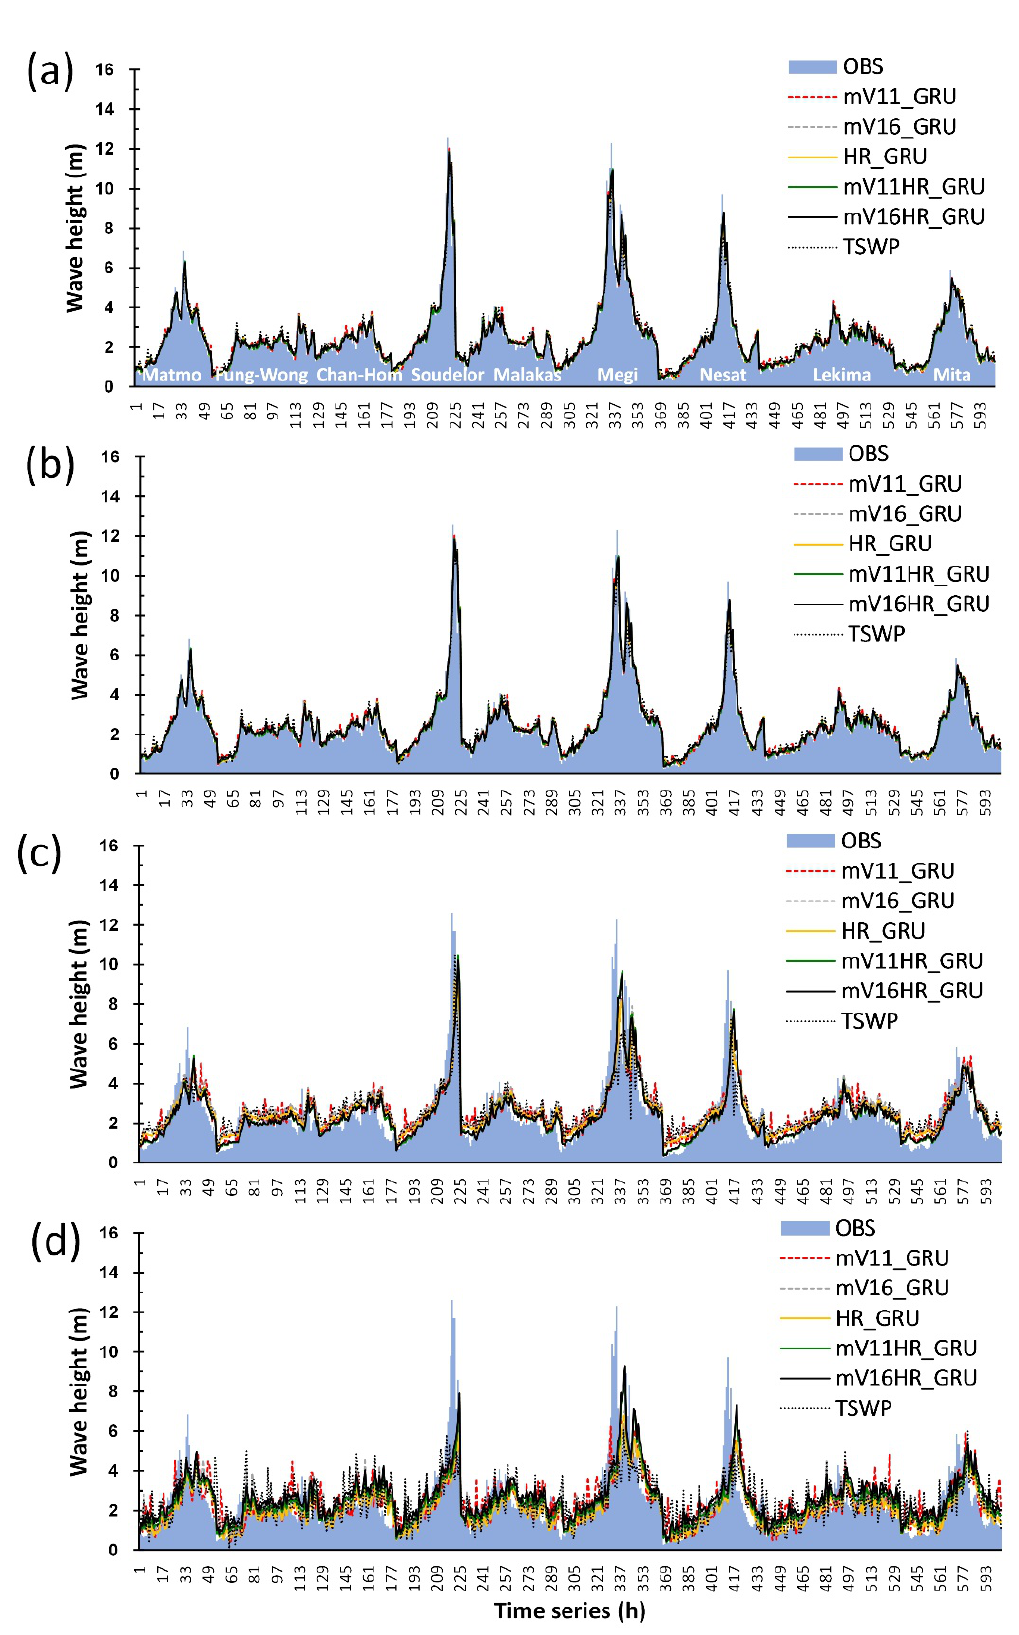
Figure 9. Wave heights predicted and measured using mV11_GRU, mV16_GRU, HR_GRU, mV11HR_GRU, mV16HR_GRU, and TSWP at the Guishandao buoy at the following lead times: ( a ) t + 1, ( b ) t + 2, ( c ) t + 4, and ( d ) t + 6.